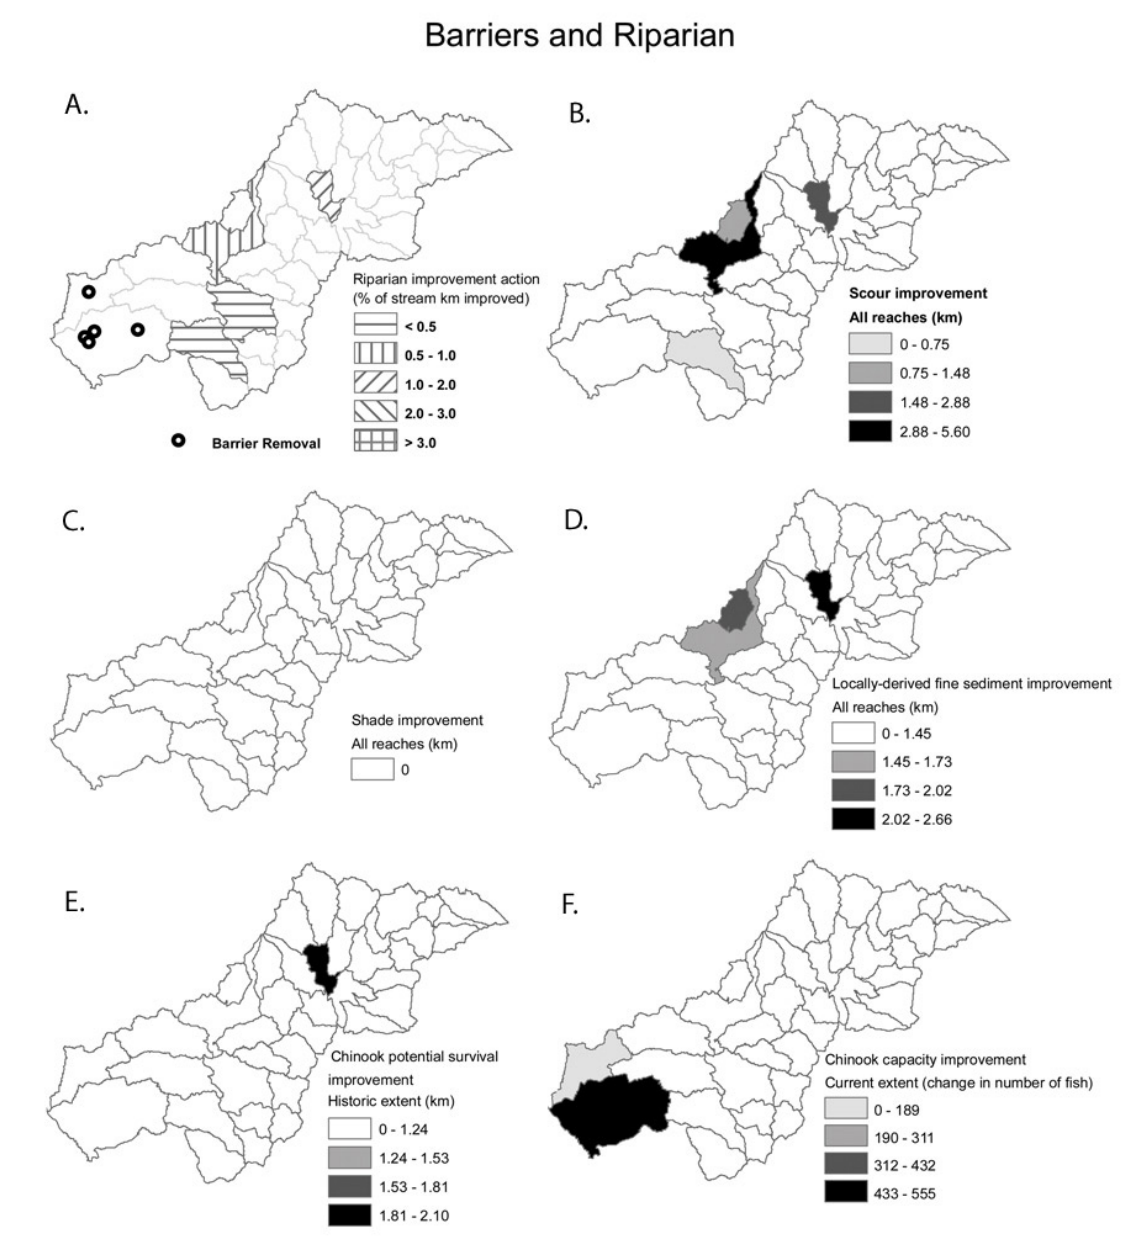
Fig. 2. Detailed description of the barriers and riparian watershed management strategy. Figure 2A describes subwatersheds targeted for riparian protection and barriers removed. Figures 2B–F describe the impact of those actions in terms of (B) scour improvement, (C) shade improvement, (D) reductions in fine sediment input, (E) potential Chinook survival changes and (F) changes in Chinook salmon capacity. Note that maps are summarized over different spatial extents as denoted in the legend for each map. The spatial allocation of funds for the barriers and riparian strategy is presented in Figure